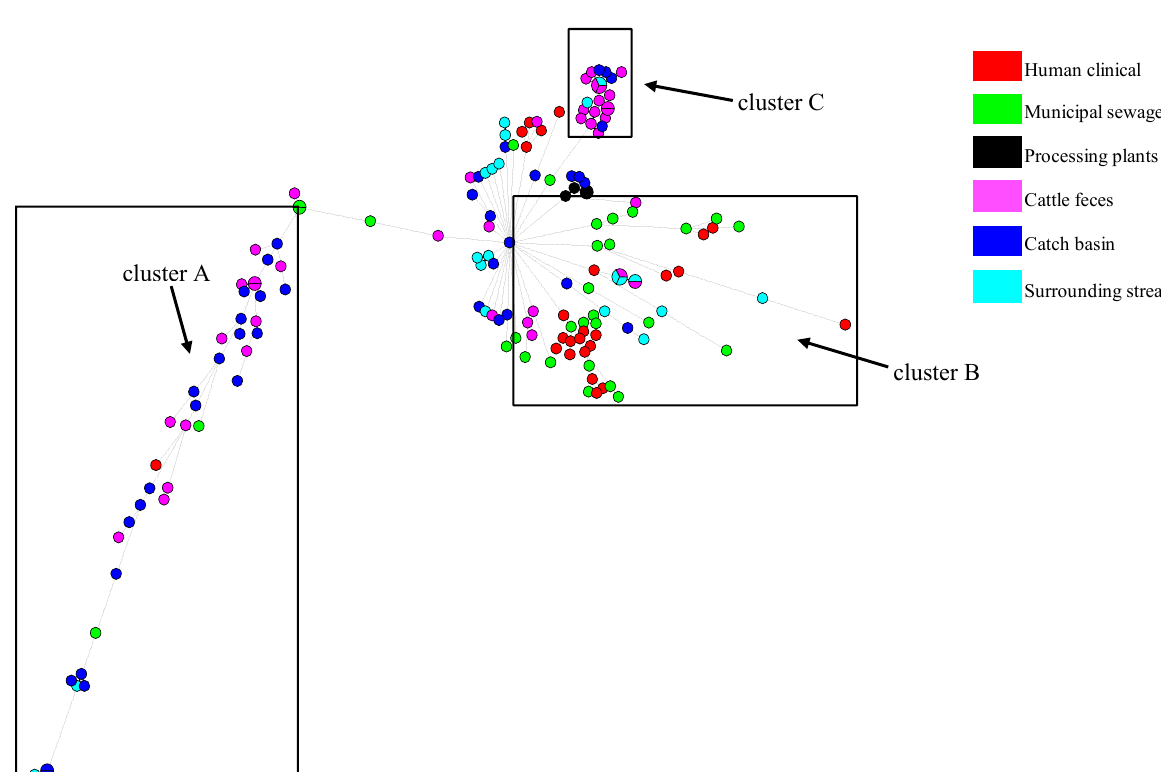
Figure 4. Minimum spanning tree (MST) based on whole-genome multi-locus sequence typing (wgMLST) profiles of 162 presumptive ESBL-producing E. coli genomes along the One Health continuum from cattle feces, catch basins, surface streams, beef processing plants, municipal sewage, and humans: The MST includes a total of 9580 wgMLST loci and was constructed with BioNumerics (version 7.6.2). Each circle corresponds to a unique wgMLST profile and is colored based on sample origin. The size of the circle is proportional to the number of isolates sharing the same wgMLST profile, while the branch lengths correspond to the number of allele differences between isolates. Boxes highlight three major clusters of isolates of cattle and human origin.